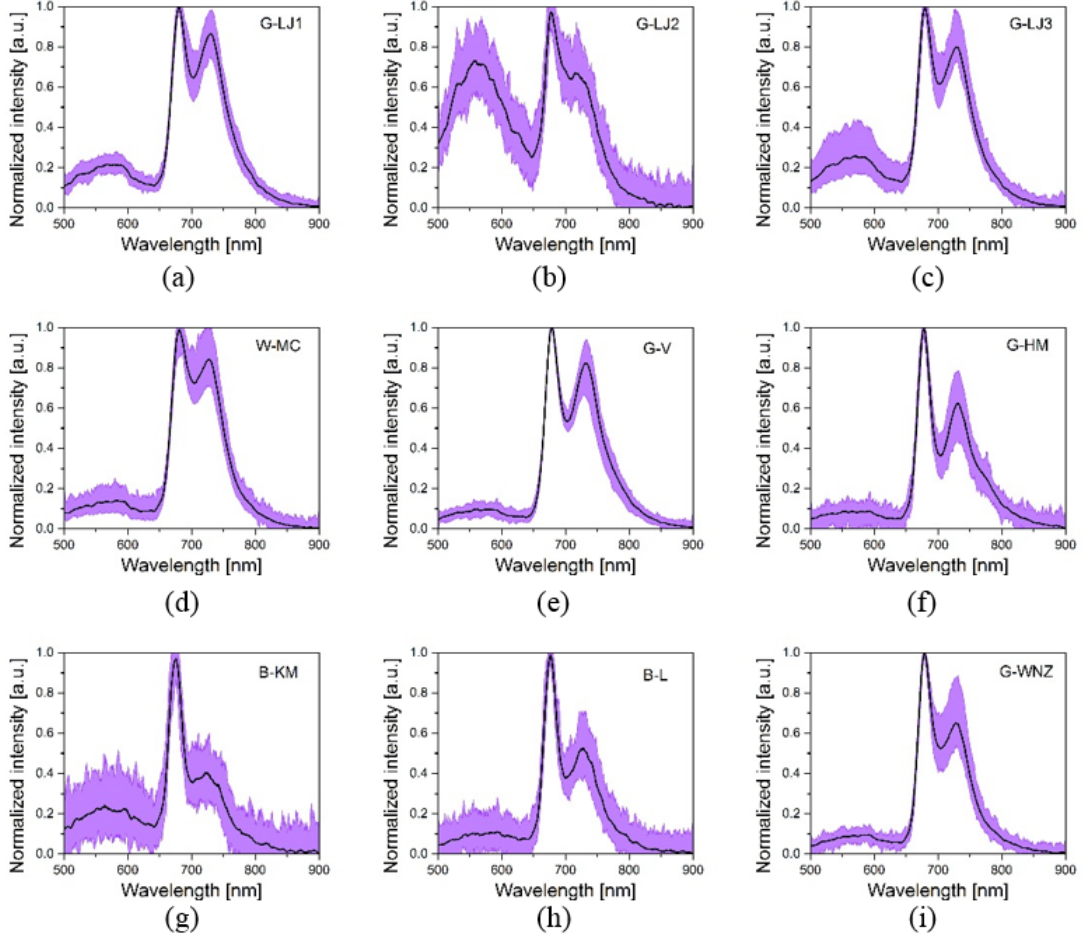
Figure 3. The fluorescence spectra of G-LJ1 (a), G-LJ2 (b), G-LJ3 (c), W-MC (d), G-V (e), G-HM (f), B-KM (g), B-L (h), and G-WNZ (i) under excitation of LED1.